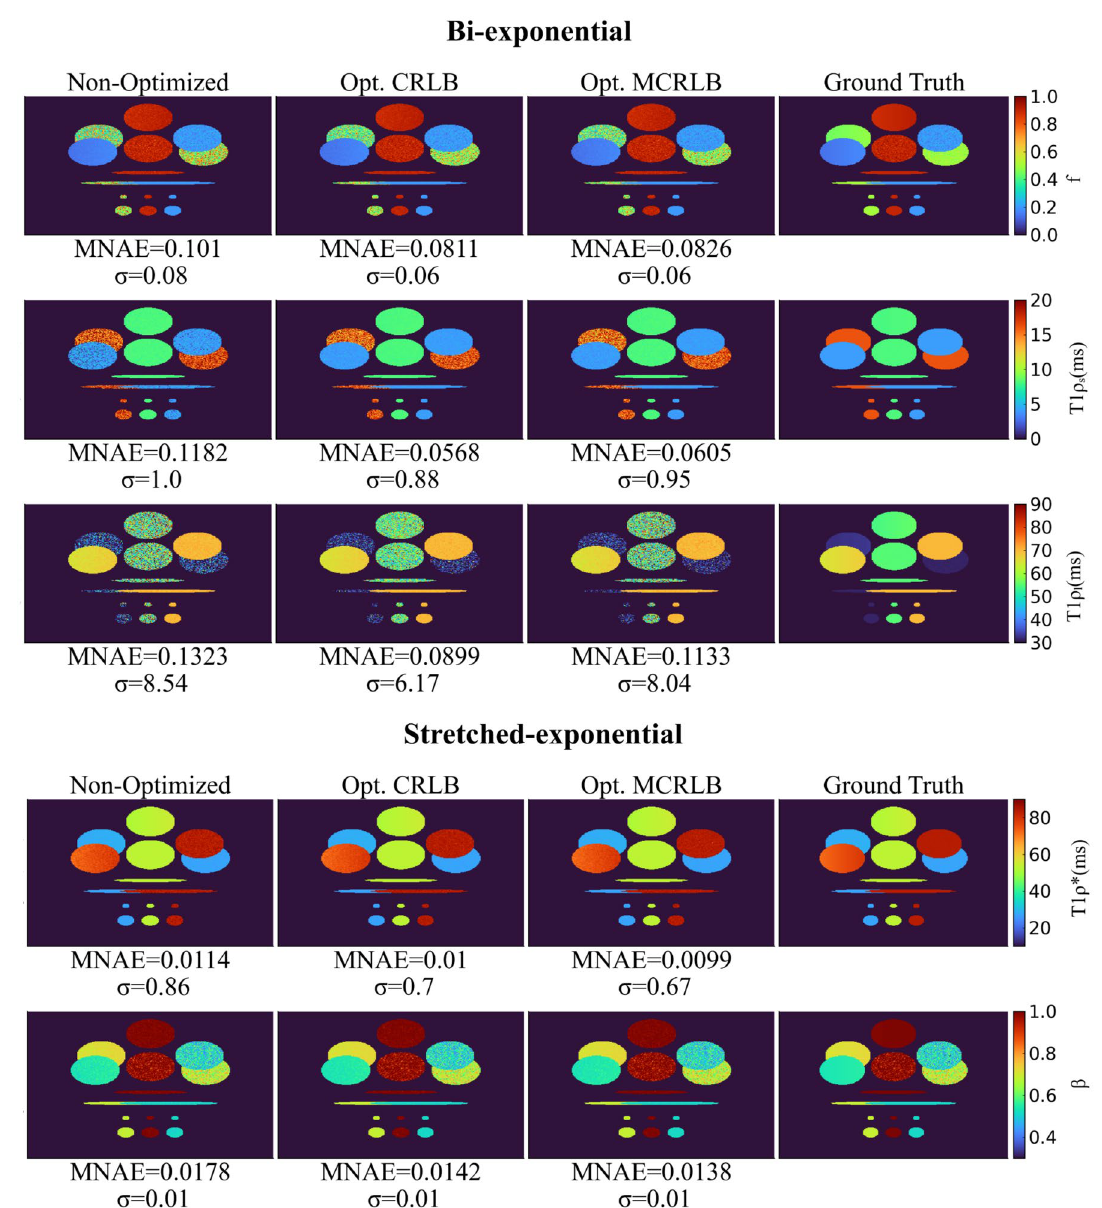
Figure 2. Parameter mapping for the bi- and stretched-exponential models with synthetic phantoms. The optimized schedules not only presented smaller MNAEs than the non-optimized ones but also presented a smaller standard deviation (σ) of the residue. Image generated in Matlab 27